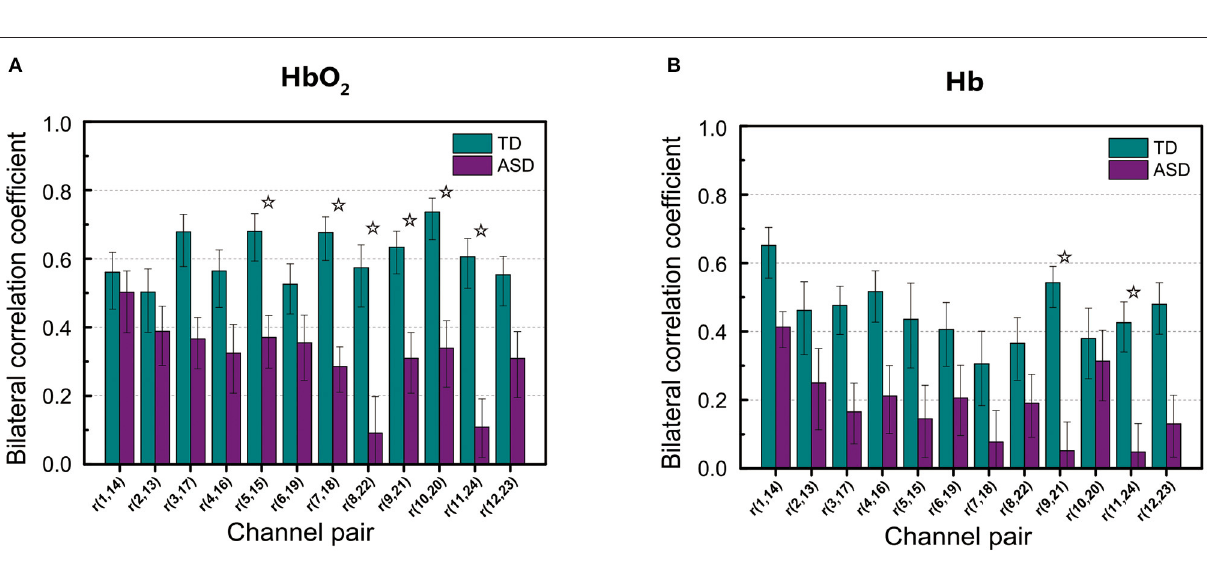
of RSFC was also calculated only over those channel pairs showing significant difference between the ASD and TD groups. The AUC value for the narrowband (FB1) was 0.867, larger